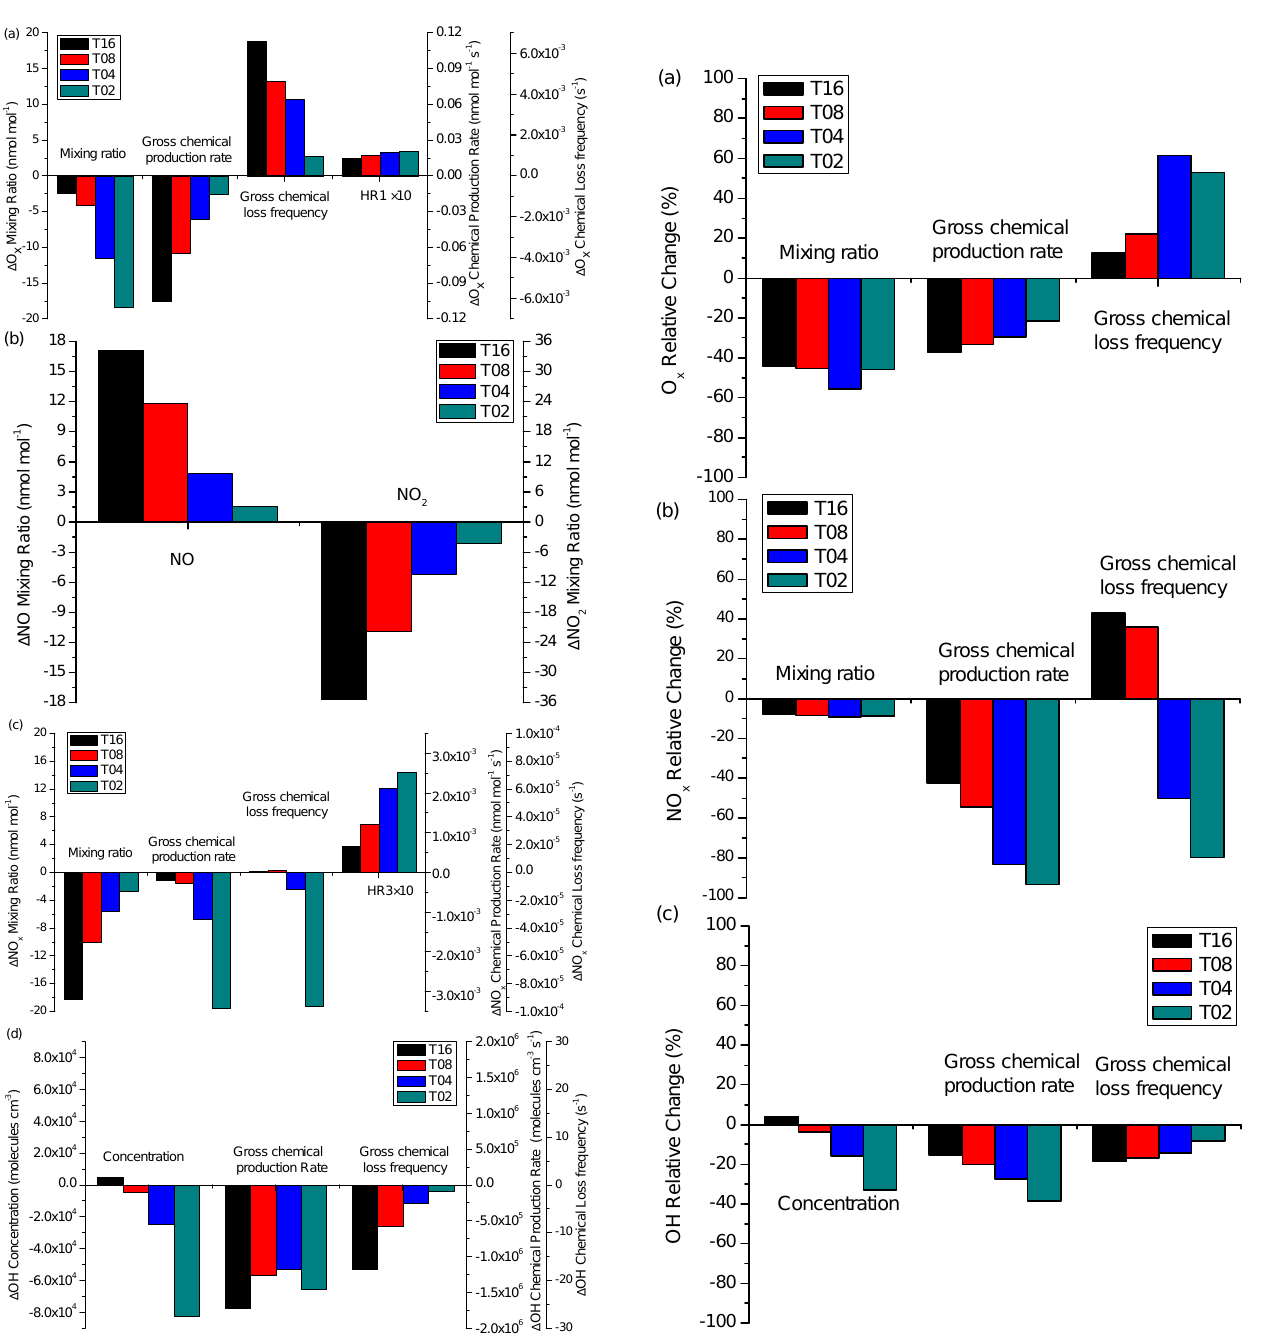
Fig. 8. Relative differences of the daily average mixing ratios and the gross chemical production rates B cp and the gross chemical loss frequencies K cl of (a) O x , (b) NO x , and (c) OH due to the hetero- geneous dust reactions. The bar sequence is the same as in Fig.